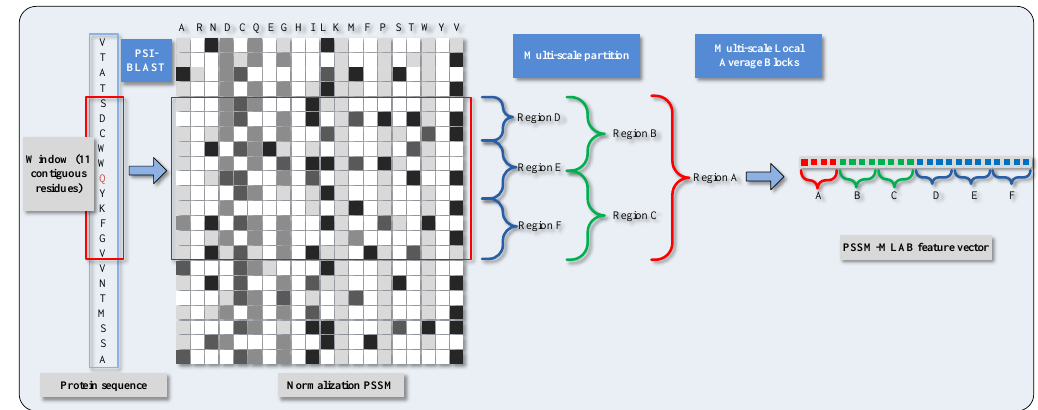
Figure 1. Schematic diagram of PSSM (Position Specific Scoring Matrix)-MLAB (Multi-scale Local Average Blocks) feature